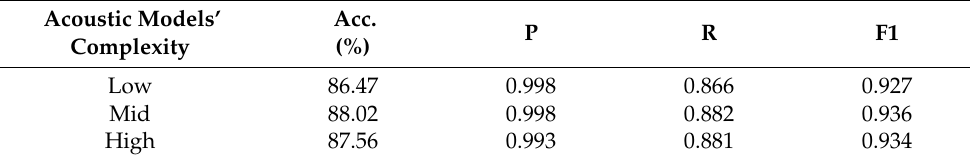
Table 1. Results of acoustic monitoring of bee audio with HMM acoustic models.